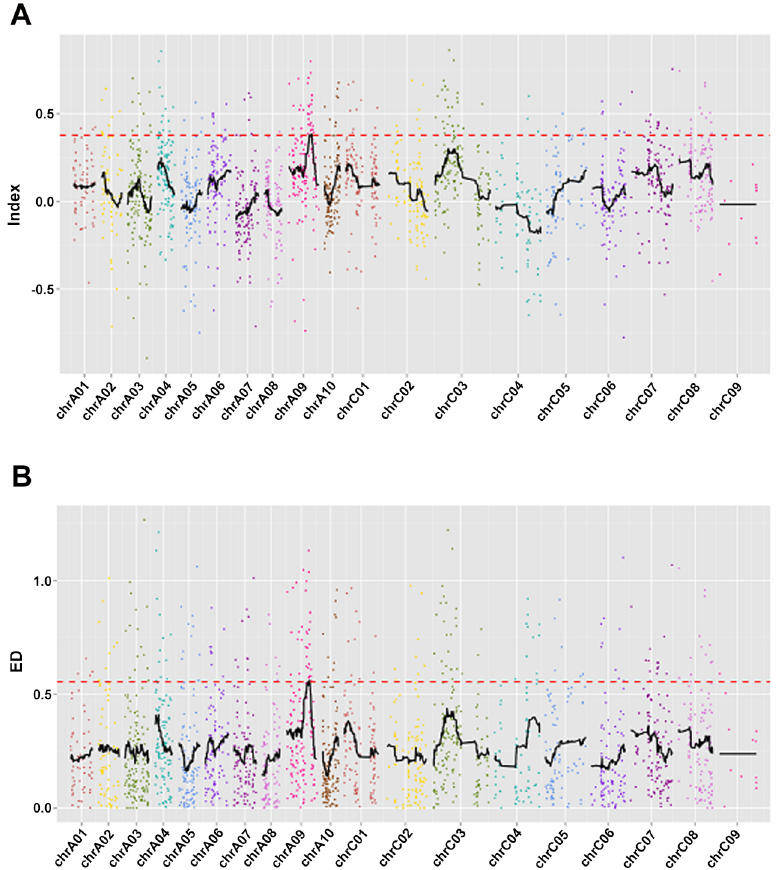
Fig 3. Identification of the hot-region for 1000-seed weight through two types of association analysis methods. (A) The results of SNP_index association analysis. The black lines show all fitting results of Δ (SNP_index), the red lines show the threshold of Δ (SNP_index). The larger the result of Δ (SNP_index) is, the stronger the association is. The association threshold was 0.3764 and 4 SLAF markers on ChrA09 significantly correlated with the seed weight trait. (B) The results of Euclidean distance association analysis. The black lines show all fitting results of ED, the red lines show the threshold of ED. The larger the result of ED is, the stronger the association is. The association threshold was 0.5532 and 4 SLAF markers on ChrA09 significantly correlated with the seed weight trait.